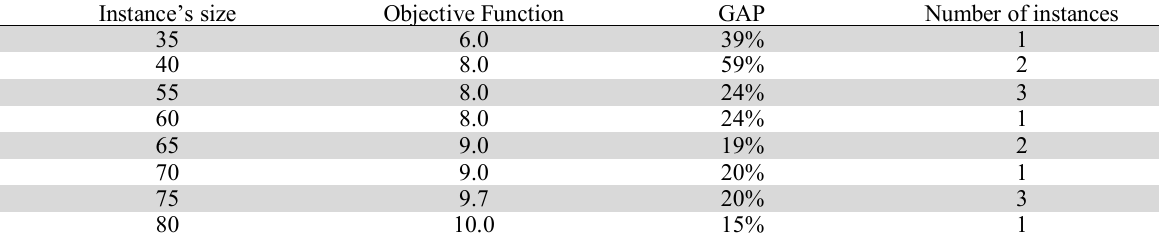
Best integer solution and GAP within 3600 s Instance’s size Objective Function GAP